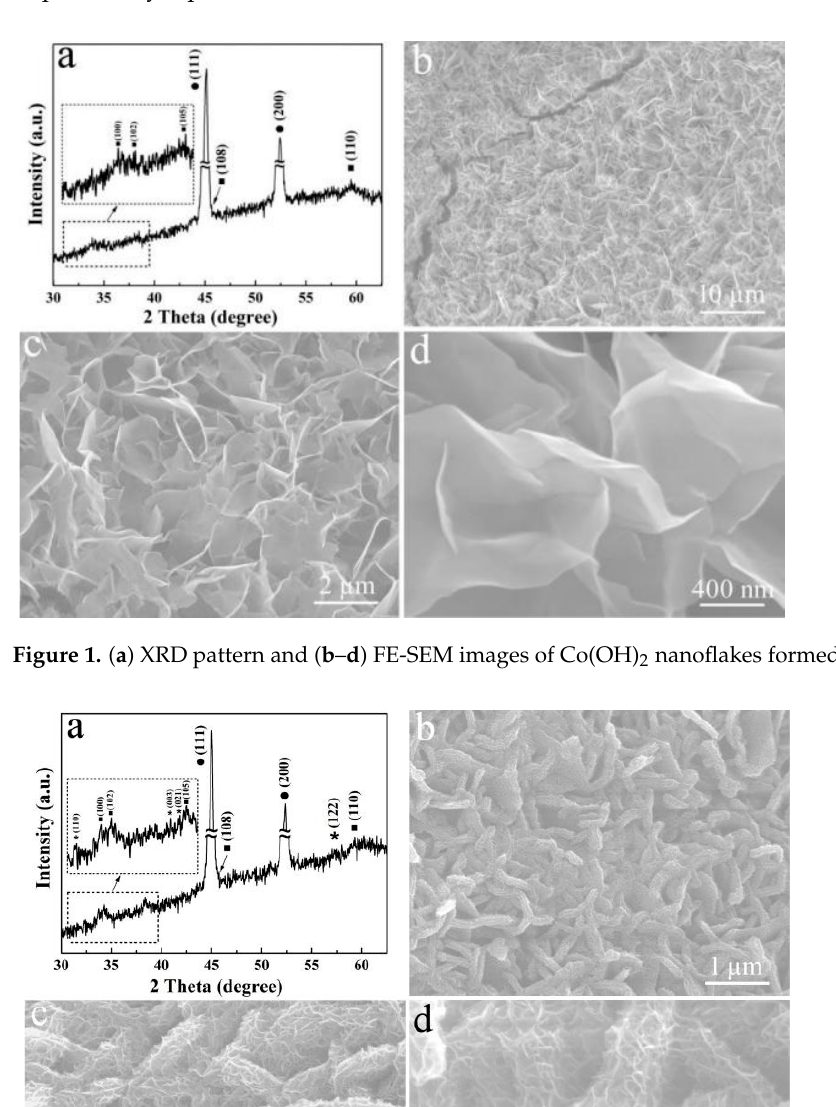
are indexed to the characteristic signatures of Co(OH) 2 [15,20,21]. The Ni 2p spectrum is exhibited in Figure 3d. Two prominent peaks positioned at 874.26 and 856.60 eV can be assigned to Ni 2p 1/2 and Ni 2p 3/2 and a spin-orbit splitting of 17.7 eV, which confirms the existence of Ni 2+ and Ni 3+ . The peaks at 880 and 861.7 eV are their satellite peaks [22,23].